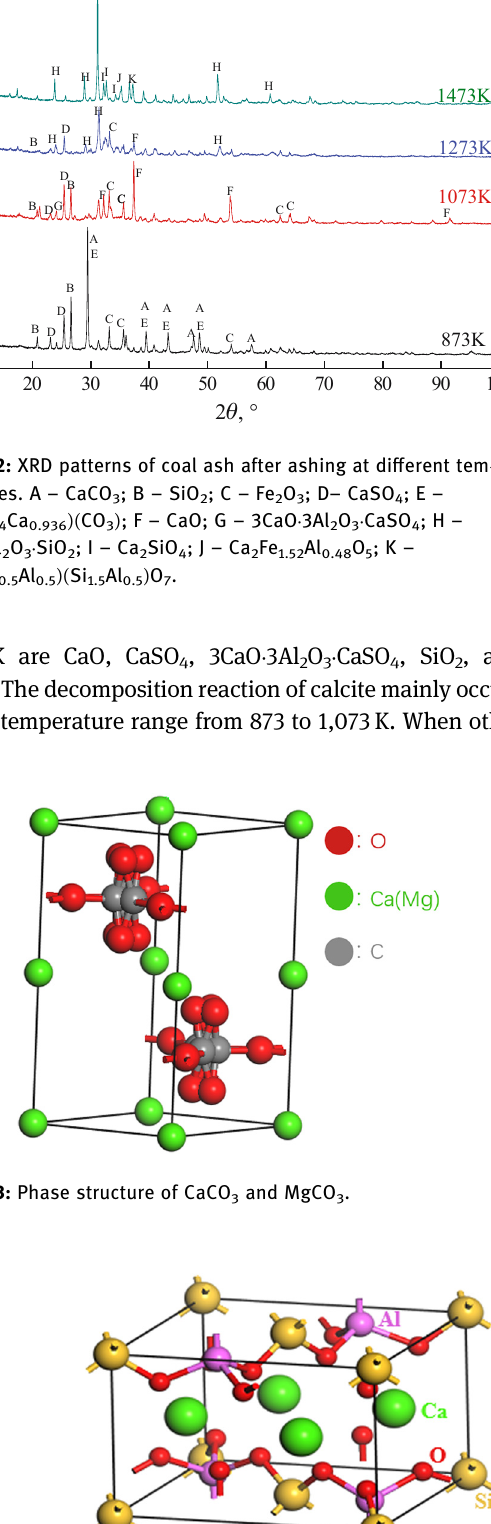
Figure 4: Structure diagram of gehlenite and